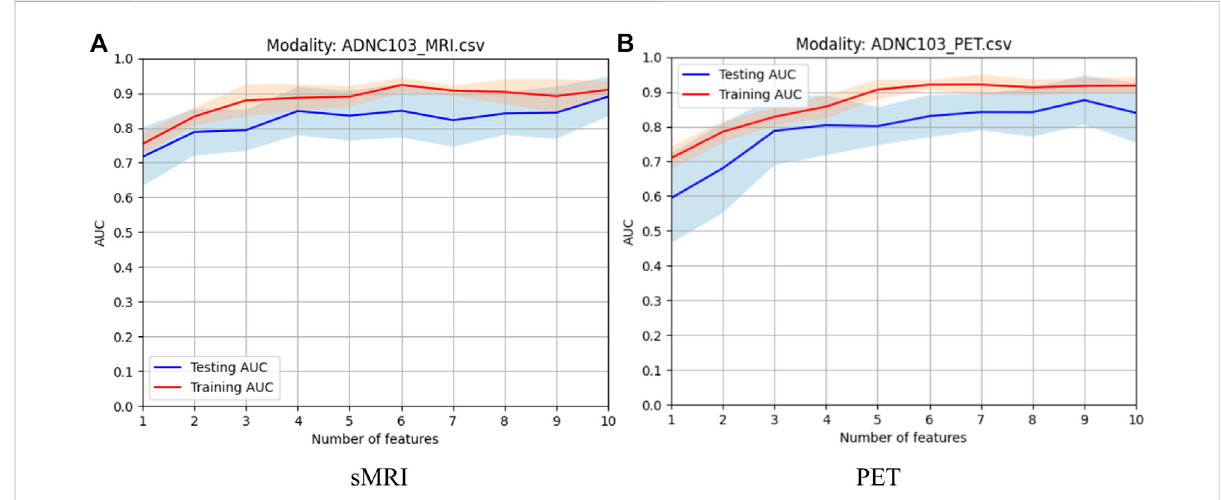
FIGURE 4 Model selection of every single modality: (A) sMRI and (B)